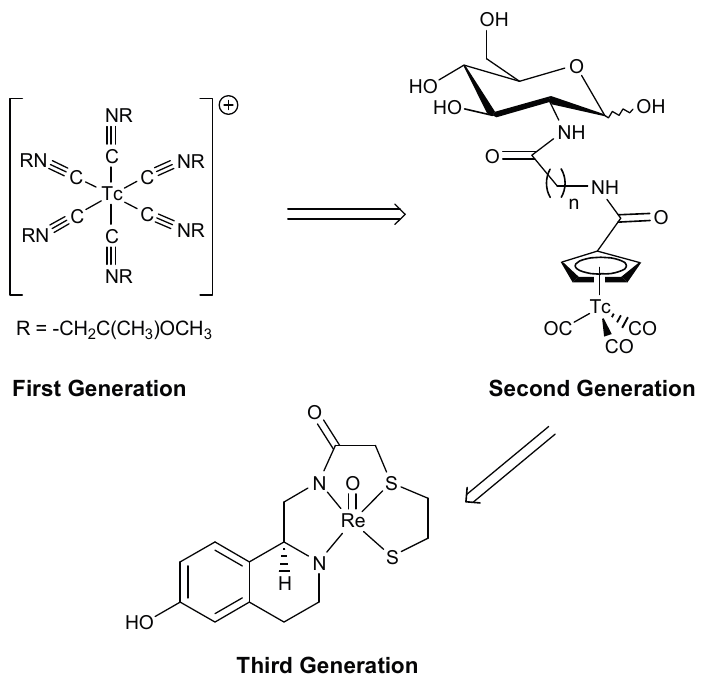
Figure 29. Evolution of technetium based